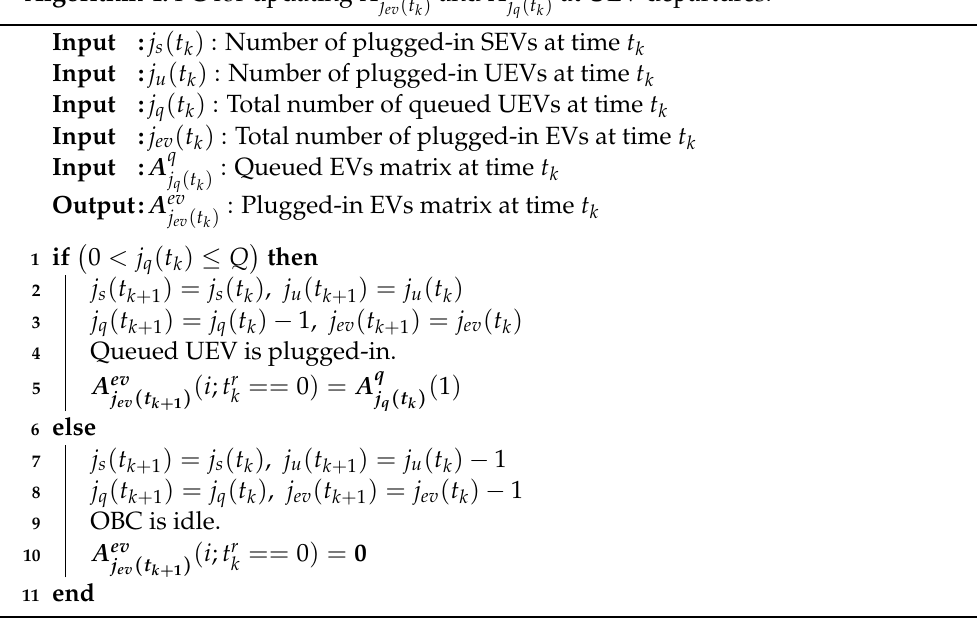
Algorithm 4: PC for updating A ev